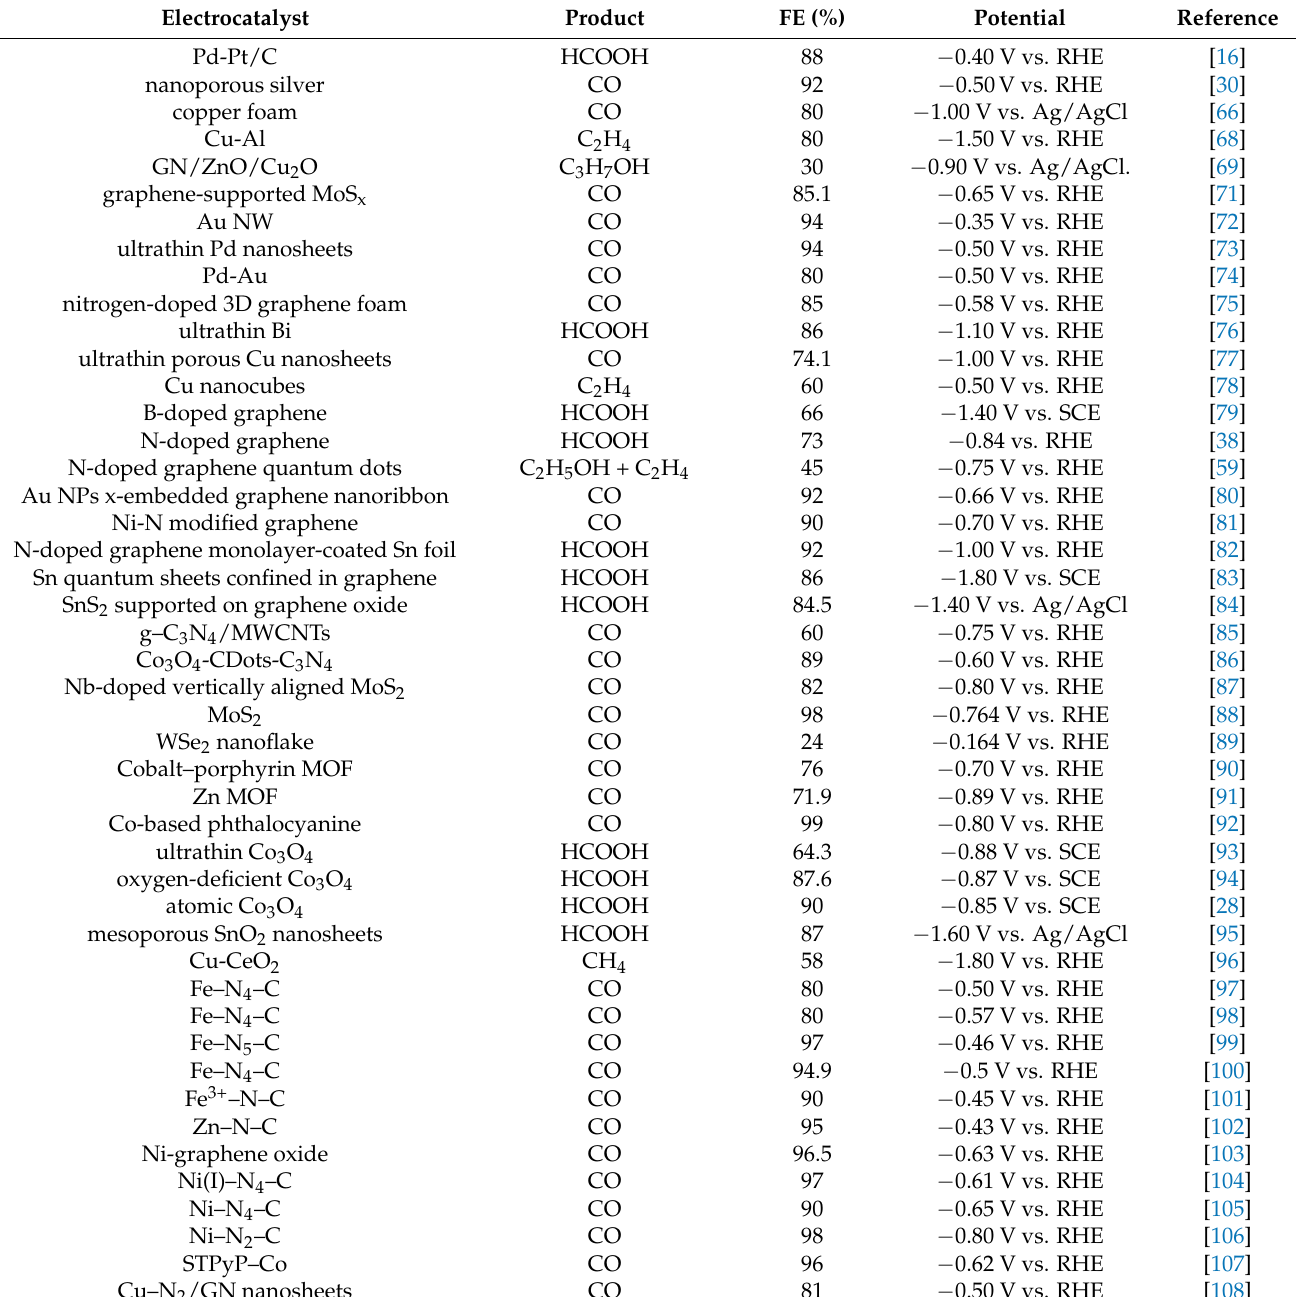
Table 2. Typical electrocatalysts in